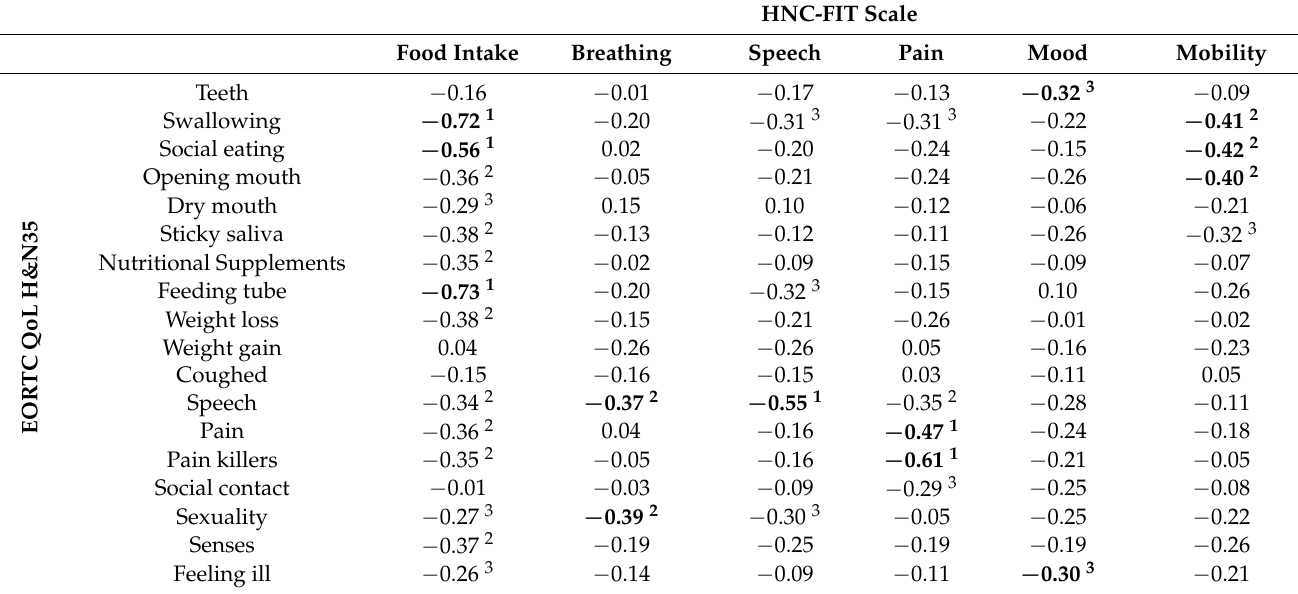
Table 3. Spearman correlation coefficients of the clinician-rated HNC-FIT scale and the 18 corresponding patient-rated EORTC QoL H&N35 subscales in 84 patients with HNC.